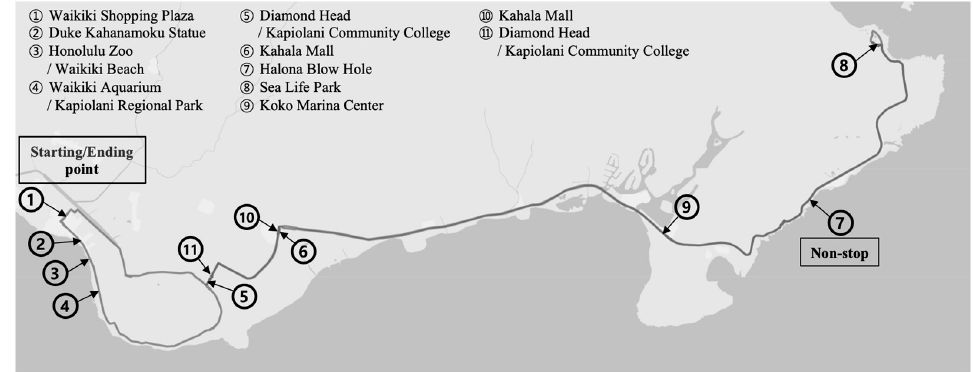
Figure 2. The entire operation route of the Blue Line of the ‘Waikiki Trolley’.